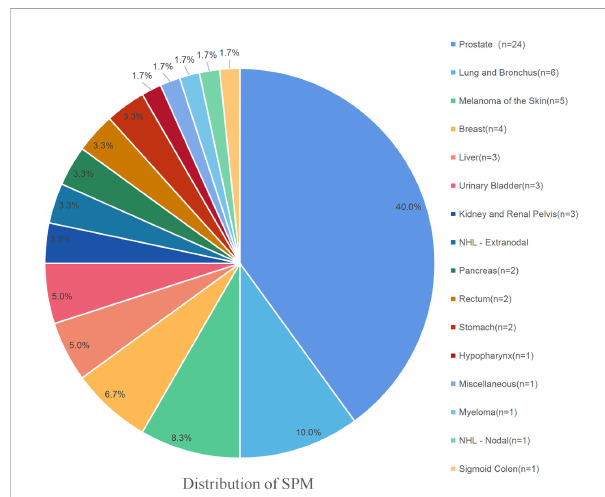
FIGURE 1 The detailed distribution of the SPMs among MBC survivors. Prostate cancer represented 24 (40%) of all SPMs, followed by lung and bronchus at 6 (10.0%), melanoma of the skin at 5 (8.3%), the secondary breast cancer at 4 (6.7%), liver at 3 (5.0%), urinary bladder at 3 (5.0%), kidney and renal pelvis at 2 (3.3%), NHL at 2 (3.3%), pancreas at 2 (3.3%), rectum at 2 (3.3%), and stomach at 2